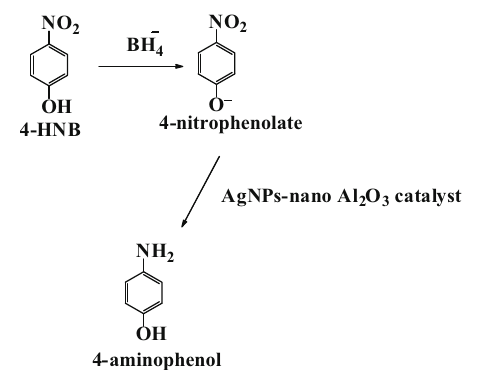
Figure 5: Reduction of 4 - HNB using green AgNPs - nano Al 2 O 3 catalyst.